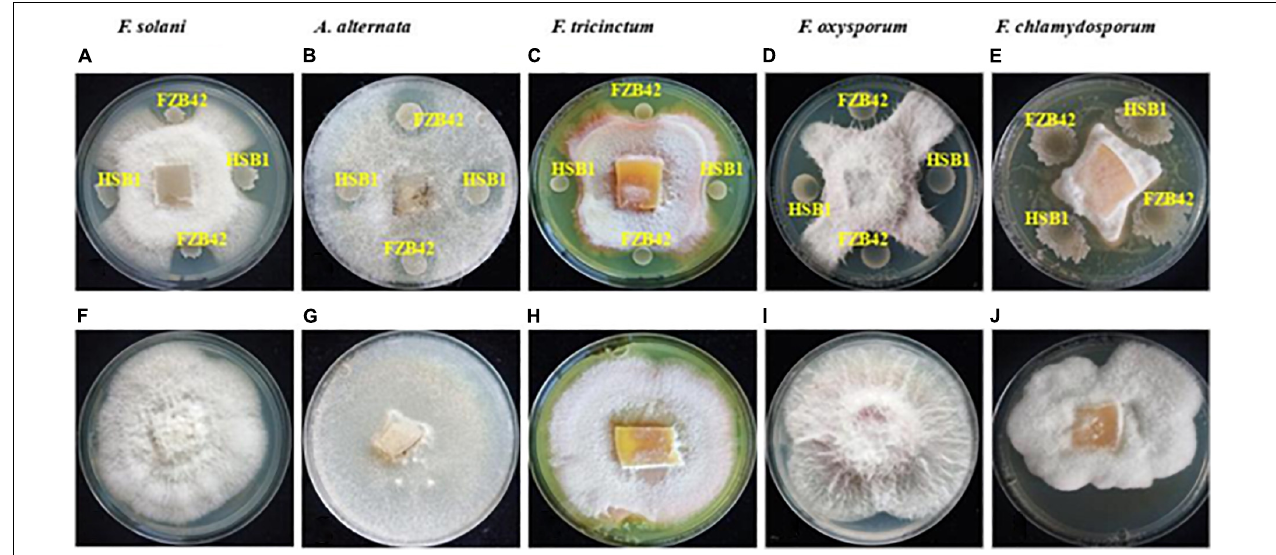
FIGURE 2 | Plate assay showing antagonistic activity of both B. amyloliquefaciens FZB42 and HSB1 against each of five fungal pathogens of Chinese wolfberry: F. solani , A. alternata , F. tricinctum , F. oxysporum and F. chlamydosporum (A–E) . Panels (F–J) are the respective controls.